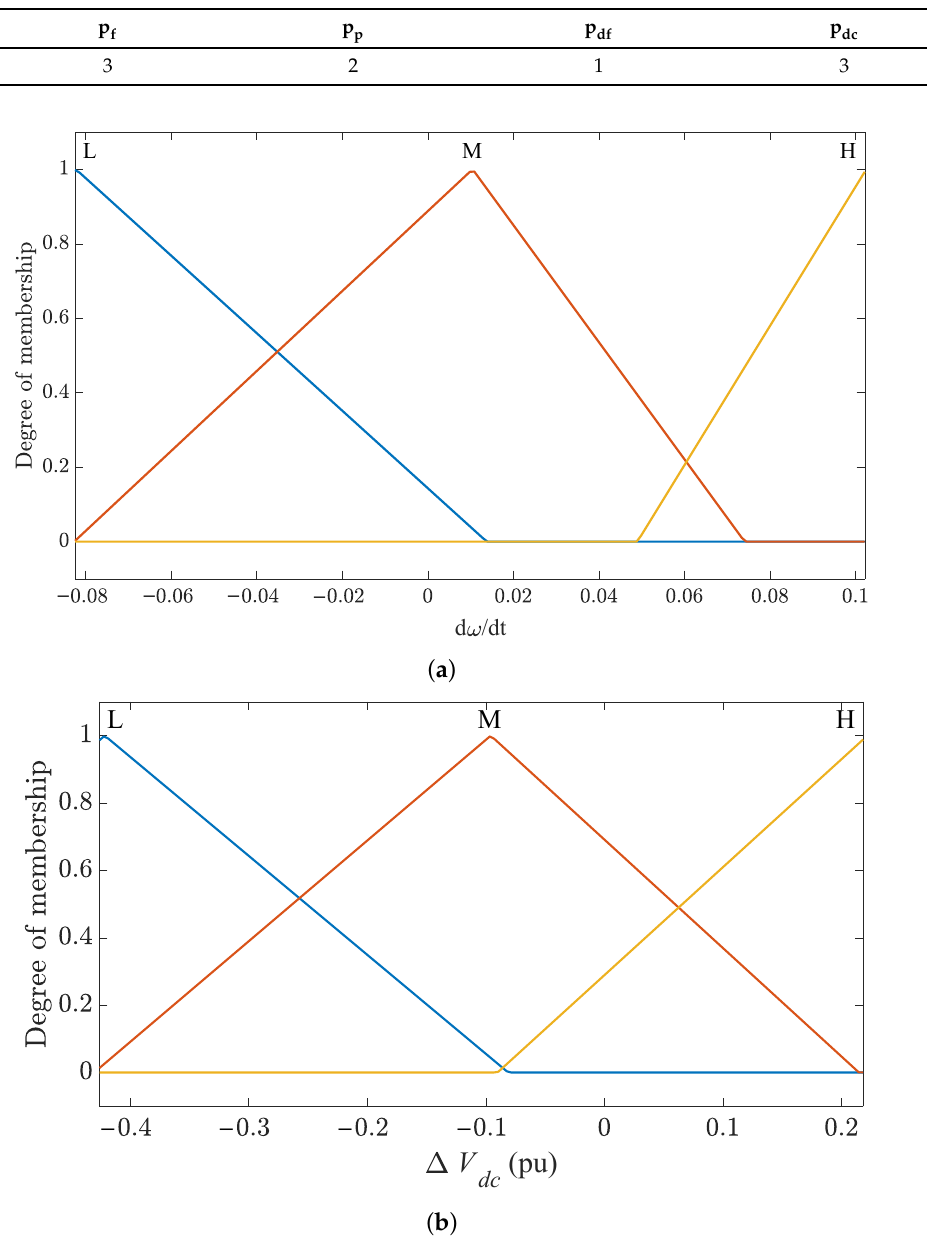
Figure 9. Optimized fuzzification membership functions of inertia-based fuzzy controller. ( a ) Opti- mized membership functions of input one. ( b ) Optimized membership functions of input